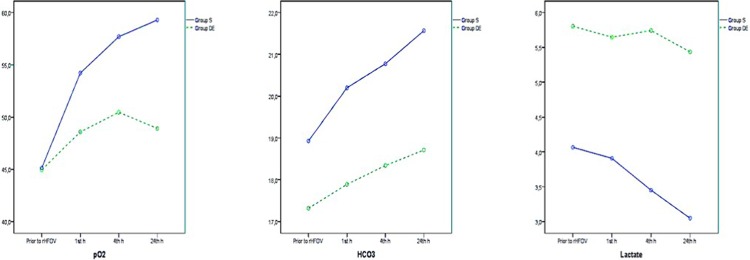
3A, 3B and 3C. Changes in pO2, HCO3 and lactate.